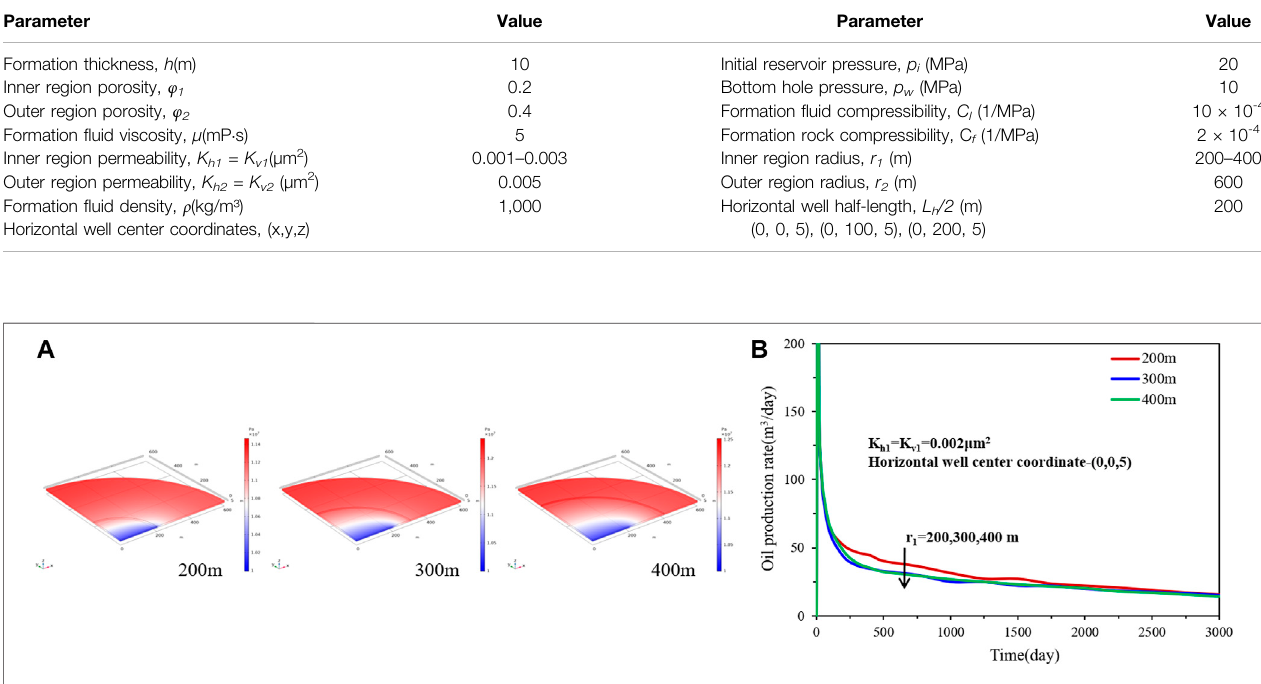
FIGURE 4 | Effect of inner region radius on (A) transient pressure and (B) rate decline performance.